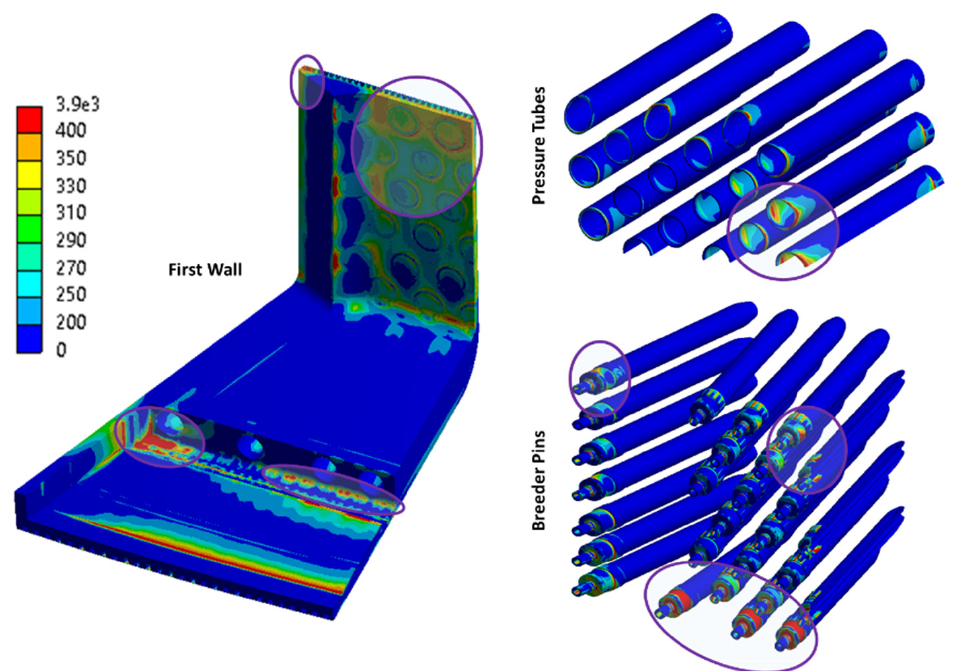
Figure 9. Identified high stressed locations according to elastic assessment.